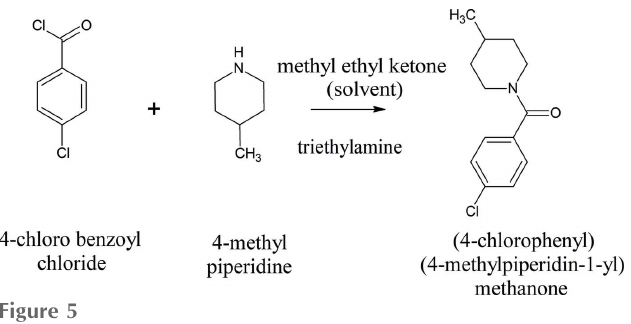
Figure 5 Reaction scheme.